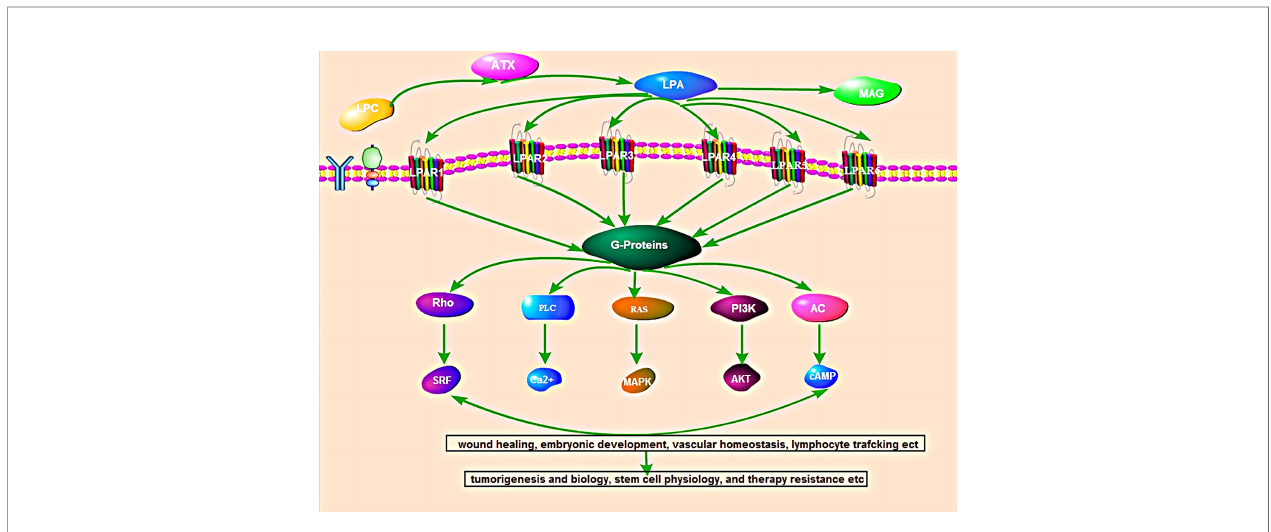
FIGURE 1 | Overview of the autotaxin-lysophosphatidic acid signaling pathway. ATX produces the lipid mediator and GPCR agonist lysophosphatidic acid (LPA) from abundantly available extracellular lysophosphatidylcholine (LPC). LPA signal through its six homologous receptors (LPAR1-6) that is binds to G proteins to activate downstream signaling pathways, including those involving Ras/Raf, RhoA, phosphoinositide 3-kinases, mitogen-activated protein kinases, and protein kinase B/mammalian target of rapamycin. The activated LPA-LPAR pathway participates in wound healing, embryonic development, vascular homeostasis, lymphocyte traf fi cking, cancer biology, stem cell physiology, and therapy resistance,